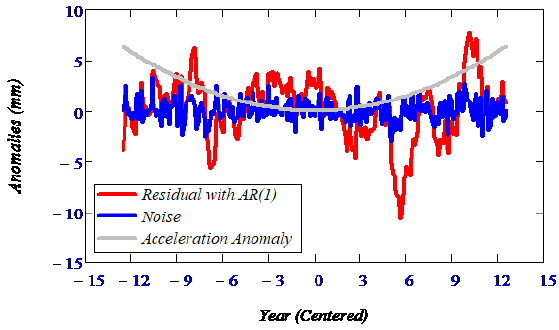
Fig. 6. The visual synopsis of the GMLS anomalies, centered at the middle epoch of the series, due by the estimated contingent and uniform acceleration only.